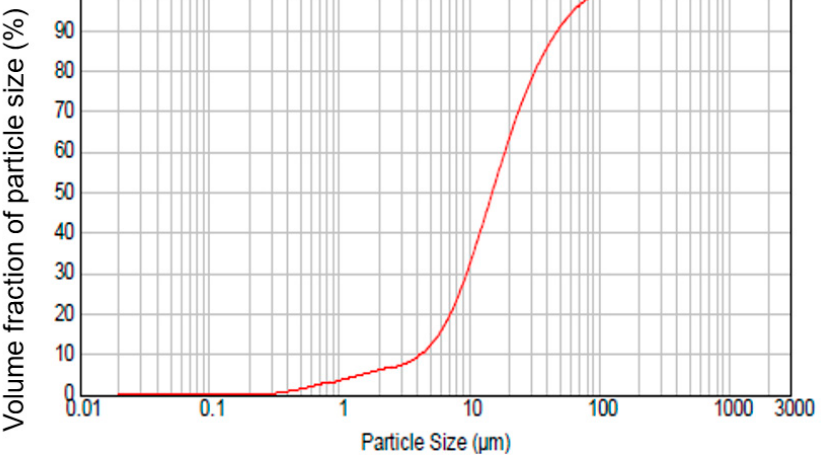
Figure 12. Particle size distribution of MgCO 3 after carbonation of synthetic magnesia.